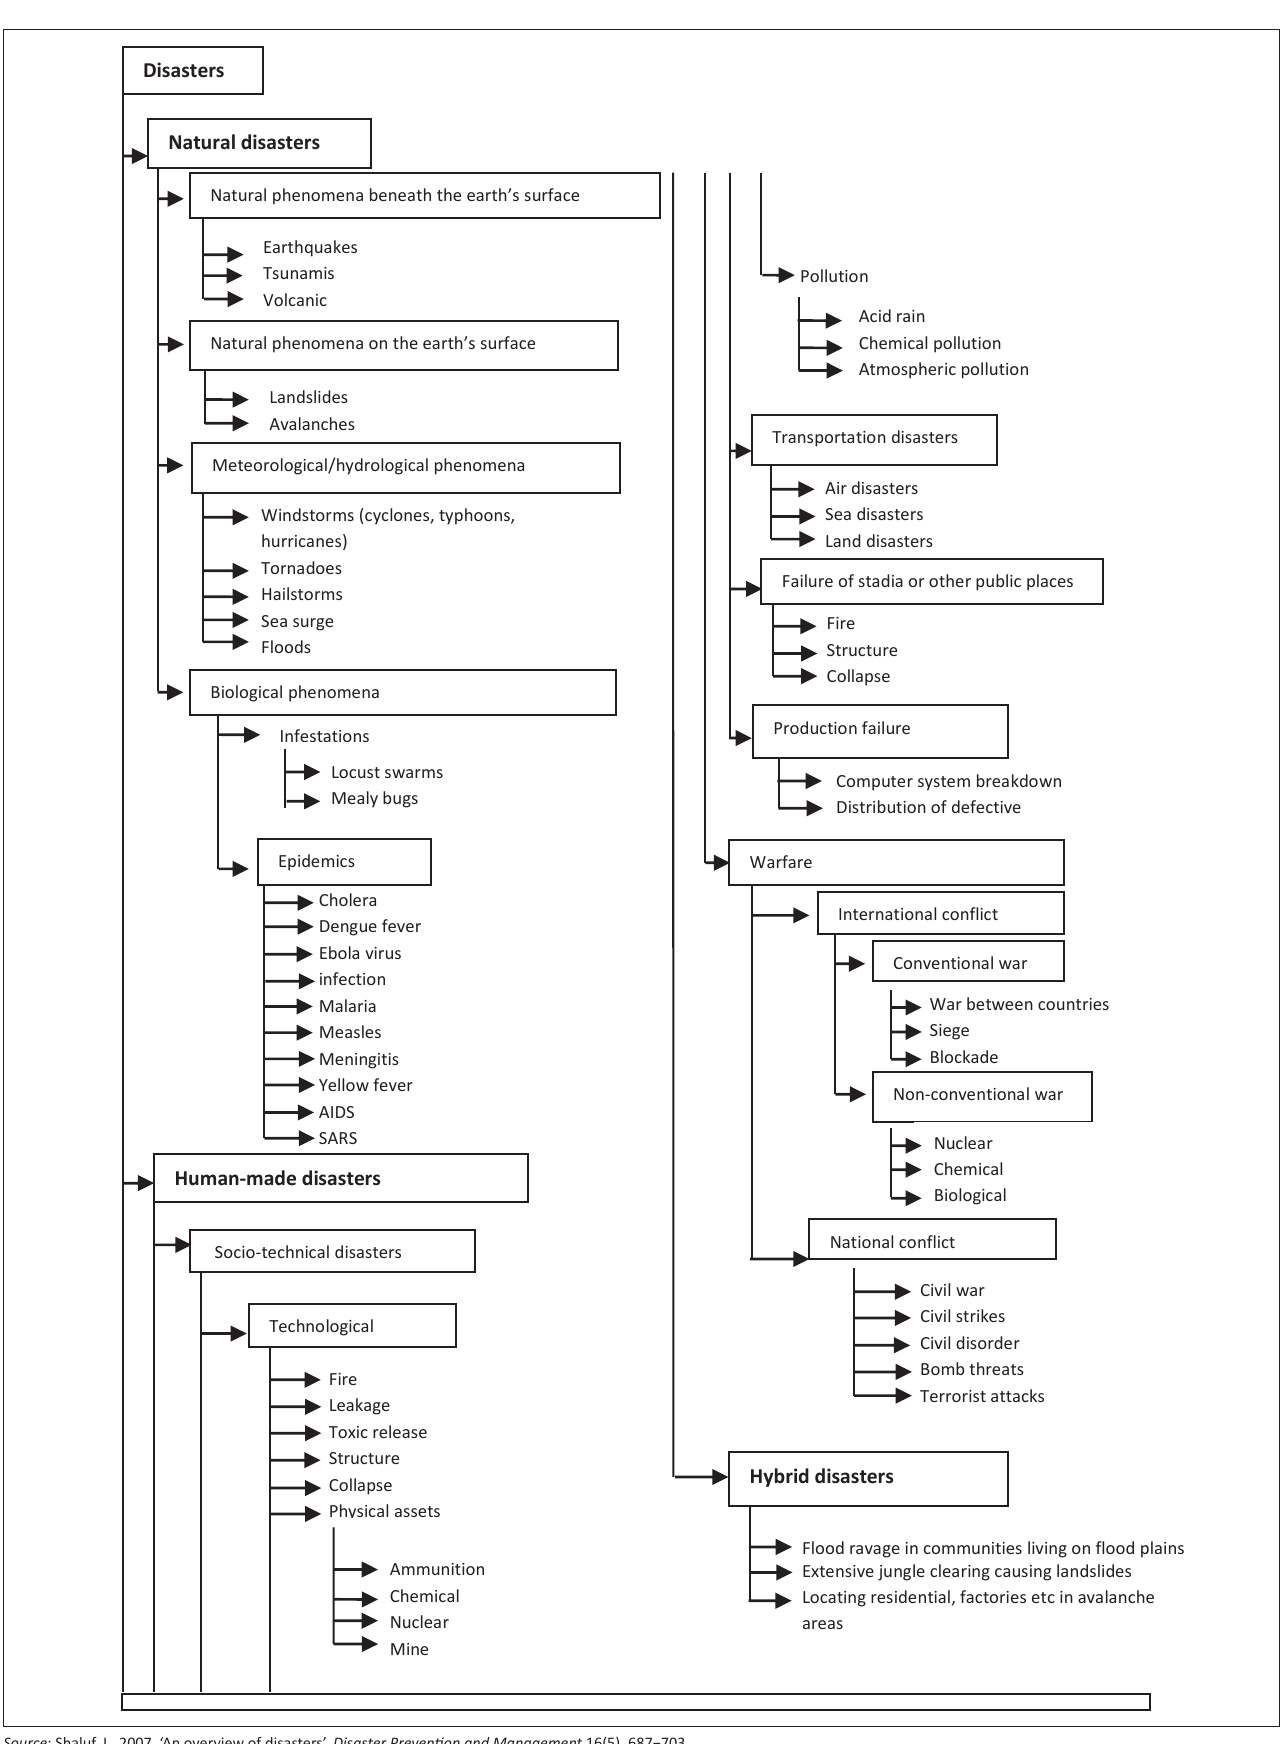
FIGURE 1: Disaster tree depicting the overview of